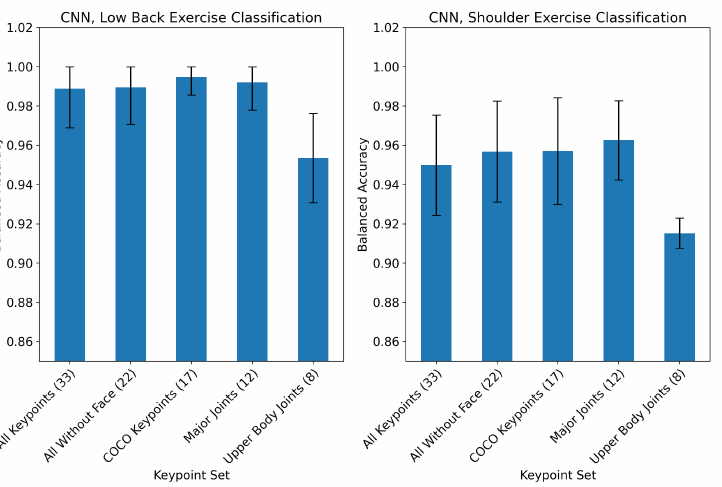
Figure 2. The effect of pose keypoint combinations on CNN classification performance for the low back ( left ) and shoulder ( right ) exercise classification tasks. The mean ± 95% CI class-balanced accuracy across 5-fold cross validation is shown. All models were trained and validated using only one camera angle for each